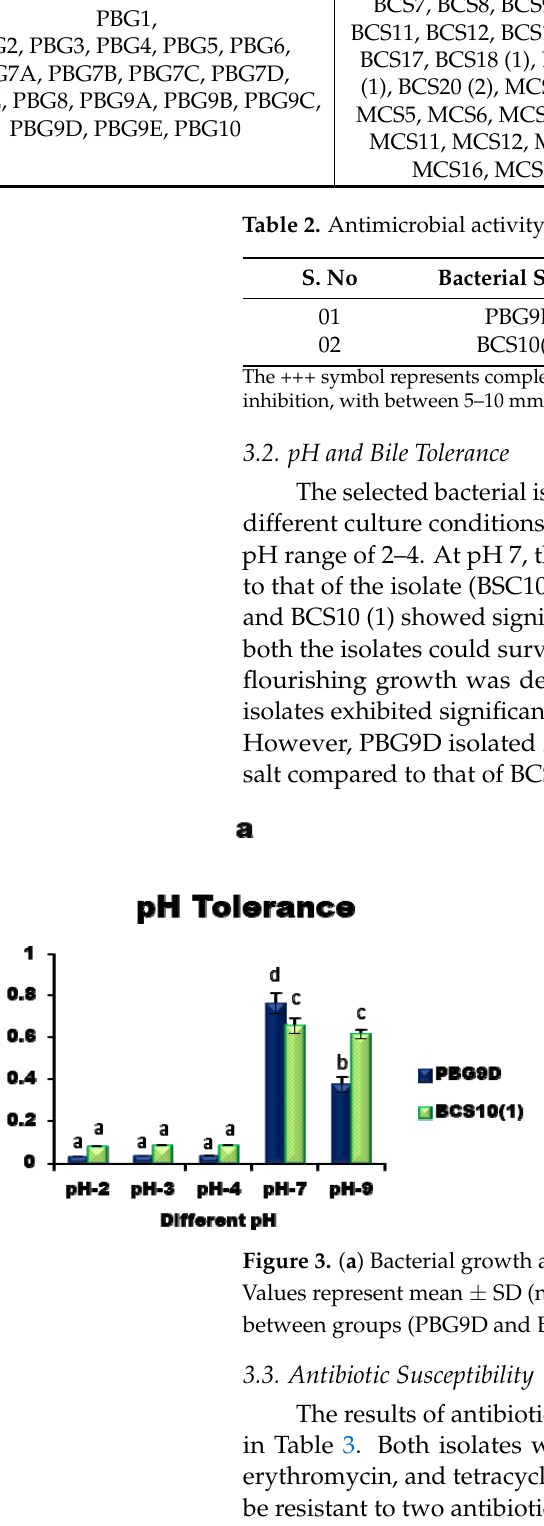
Table 3. Antibiotic susceptibility of selected bacterial isolates.